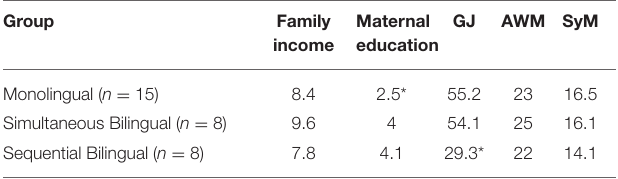
TABLE 2 | SES and screening tests score means for child participants.